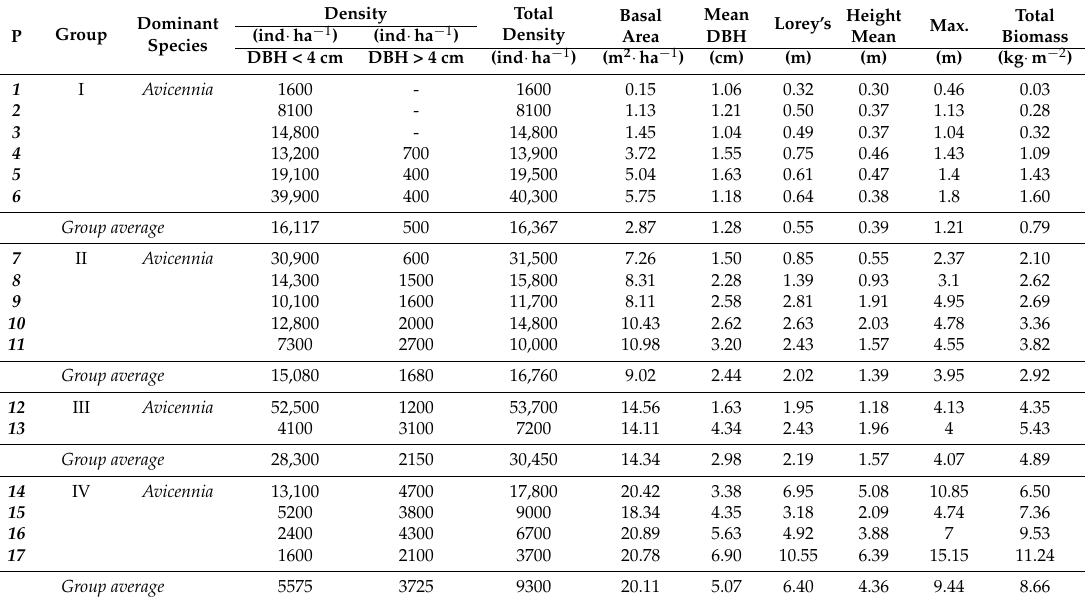
Table 4. Structural attributes of the plots showing the formed